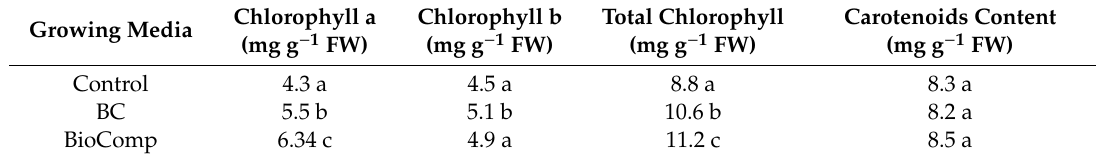
Table 5. Chlorophyll and carotenoids contents of Syngonium podophyllum grown in different growing media. Growing Media